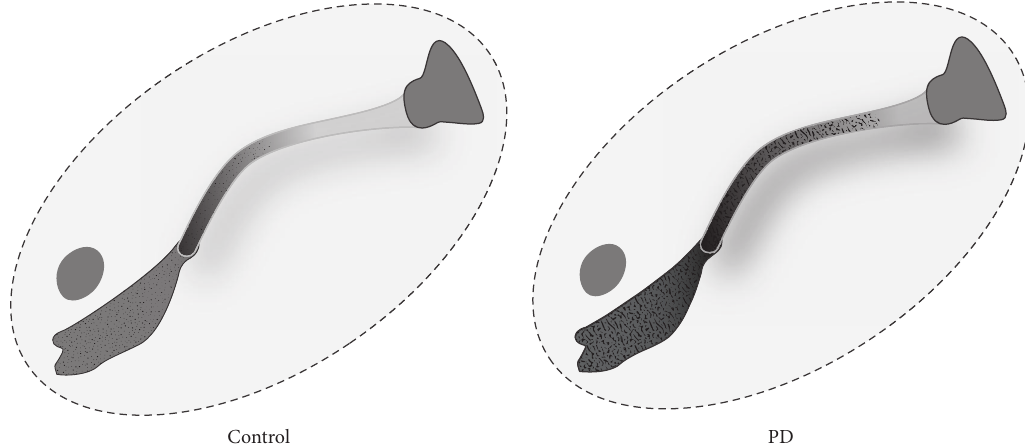
Figure 7: Illustrated trends of iron deposition in the FN and SN in control and PD